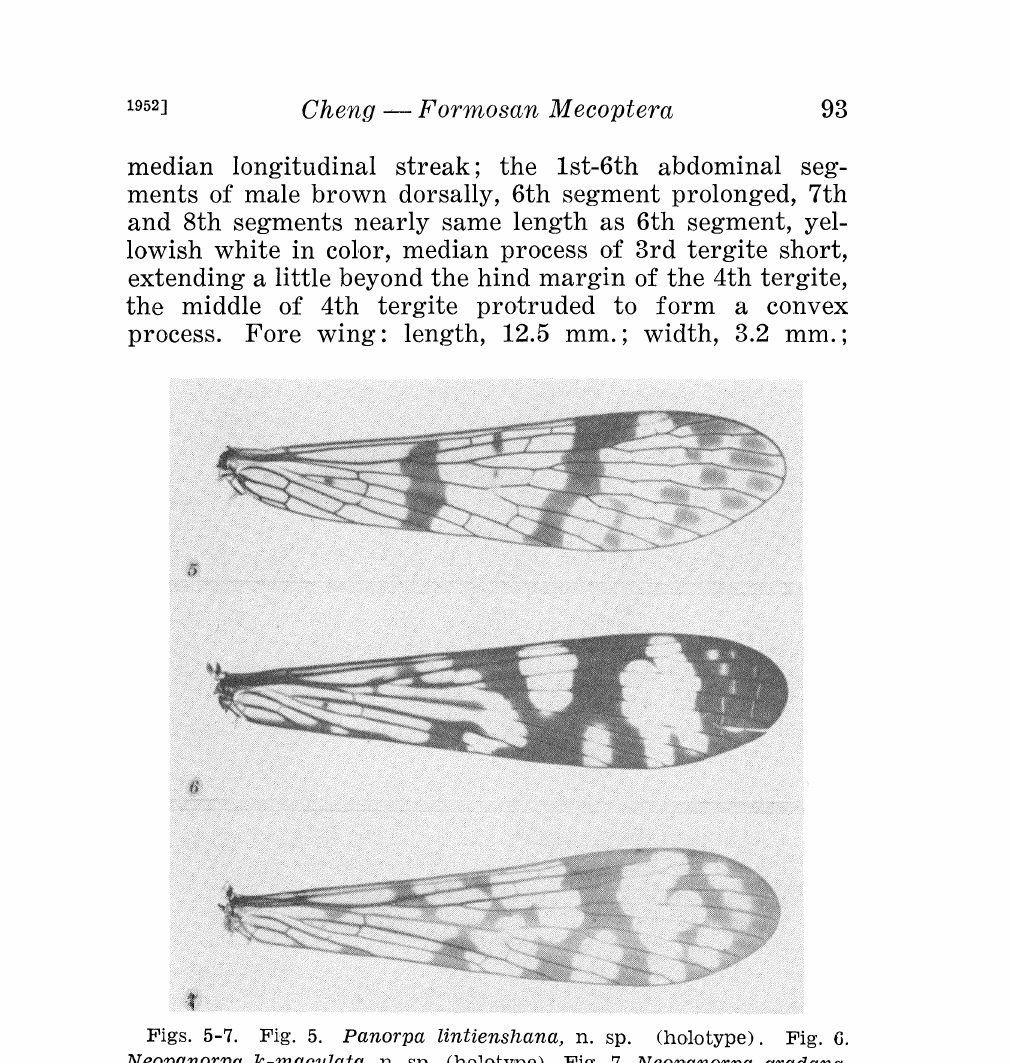
Figs. 5-7. Fi.g. 5. Panorpa lintienshana, n. sp. (h(lotype). Fig. 6. Neopanorpa k-maculata, n. sp. (h.olo.t.ype). Fig. 7. Neopanorpa gradana, n. sp.